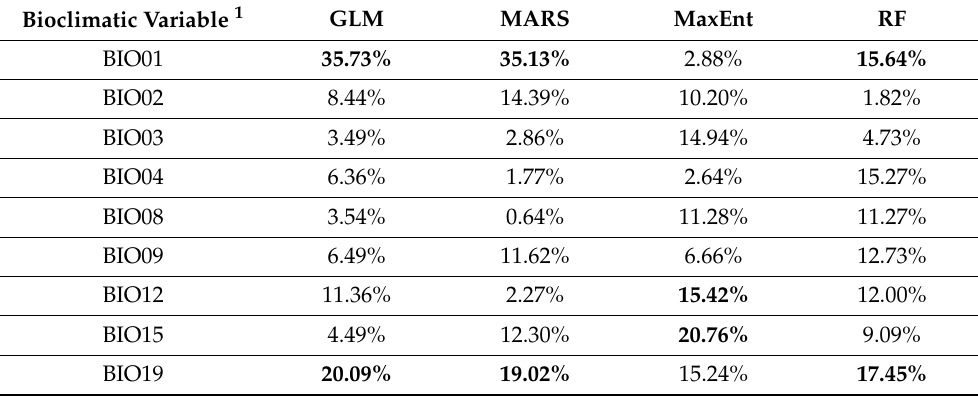
Table 3. Relative contribution of each bioclimatic variable to Generalized Linear Model (GLM), Multivariate Adaptive Regression Splines (MARS) model, MaxEnt model, and Random Forest (RF) model to estimate the suitability of Mediterranean Europe for Toumeyella parvicornis .